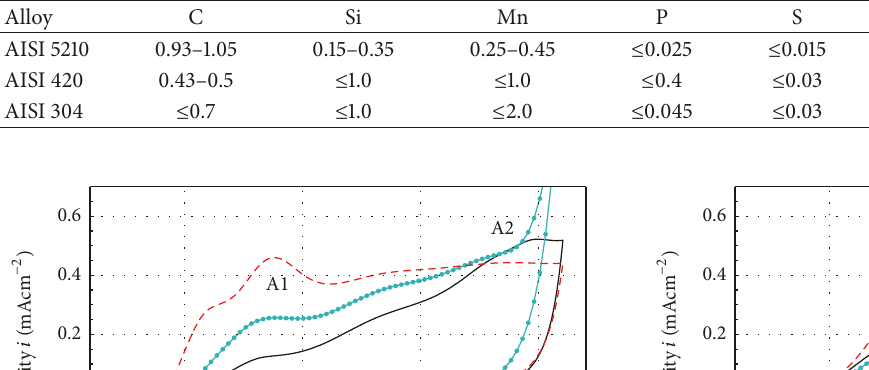
Table 1: Standard range of chemical composition of the working electrodes (wt.%) [34].